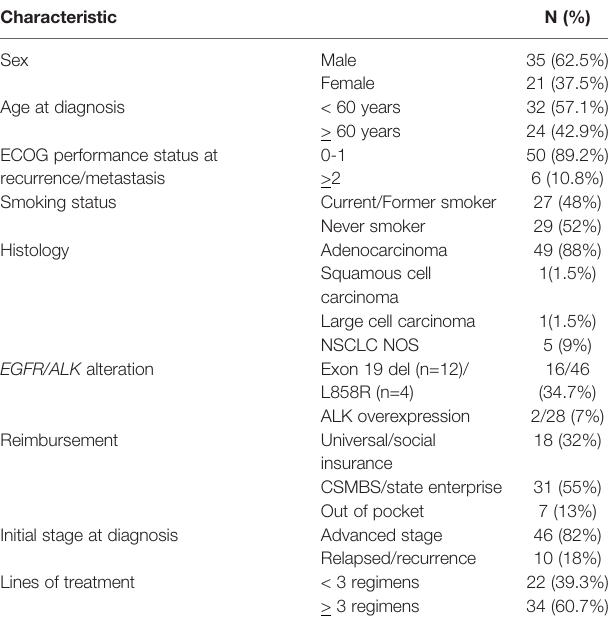
TABLE 1 | Demographic characteristics of participants in this study.